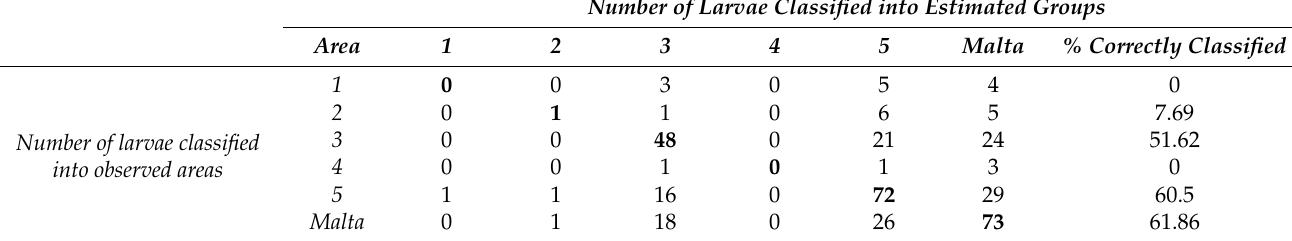
areas 5 and Malta, where more than 60% of cases were correctly classified (Table 3). Table 3. Morphometry confusion matrix. Classification applied on normalized morphometric parameters by random forest analysis. Bold numbers indicate the number of larvae correctly